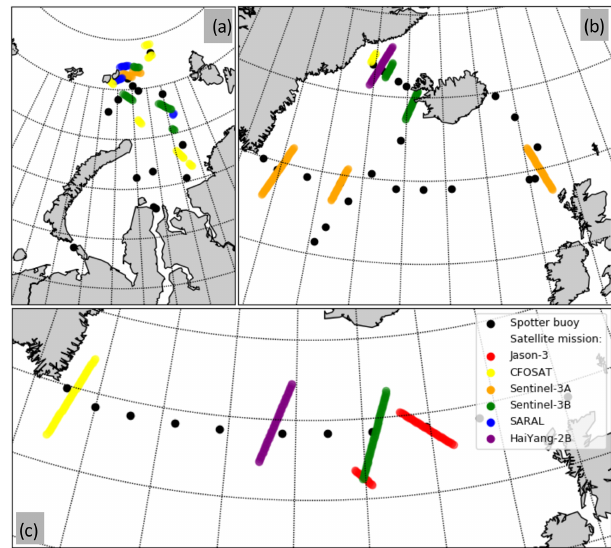
Figure 8. Overpasses of satellite altimeter missions (Jason-3, CFOSAT, Sentinel-3A, Sentinel-3B, SARAL, or HaiYang-2B) over the observational domains. Black dots indicate locations where wave parameters were measured simultaneously with the Spotter wave buoy and SeaVision (Table